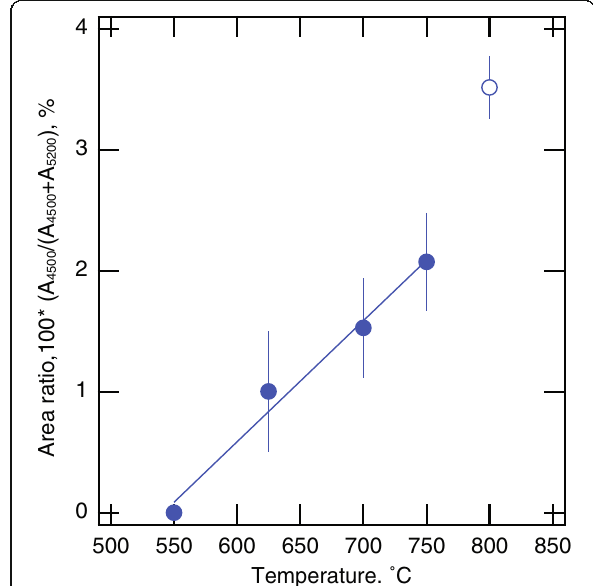
Fig. 3 Relationship between the area of the band centered near 4500 cm − 1 and that near 5200 cm − 1 (expressed in percent) from FTIR absorption spectra of fluid. The data point from 800 °C (open circle) is from single-phase fluid. The straight line is a simple linear fit to the data point (not including that from single-phase fluid at 800 ° C); area ratio = 0.0100 ± 0.0009 – 5.4 ± 0.5